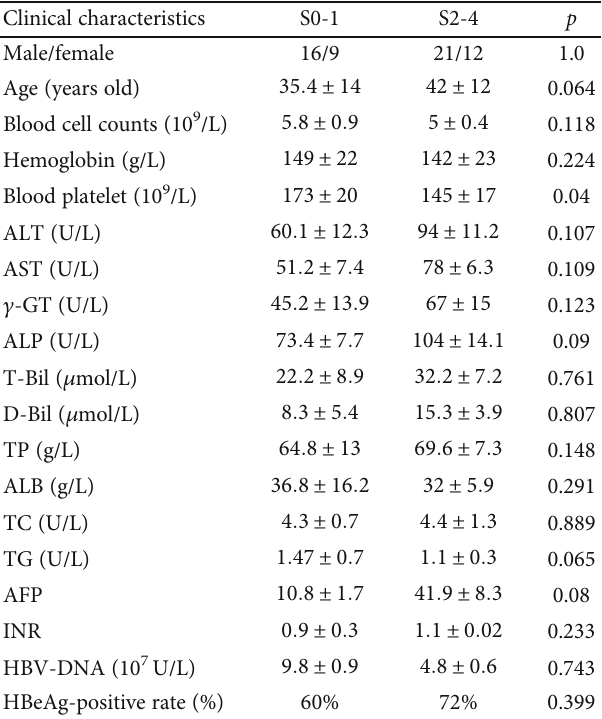
Table 2: Clinical characteristics of the CHB nonsigni fi cant liver fi brosis group (S0-1) and signi fi cant liver fi brosis (S2-4) cases ( (cid:1) x ± s ).